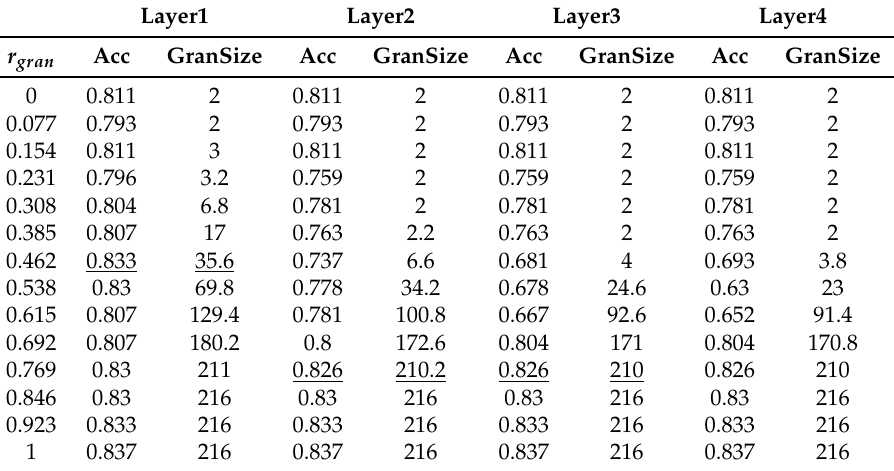
Table 18. CV-5; Result of experiments for multi-layer c-d granulation with use of kNN classifier; data set Heart disease; r gran = Granulation radius, Acc = Average accuracy for the considered layer, TRNsize The mean size of granular decision system for the considered layer.